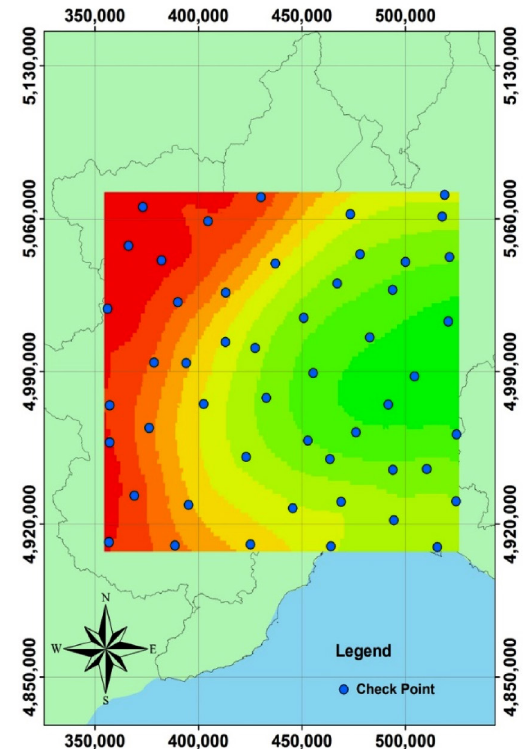
Figure 5. The distribution of the 50 check points in the study